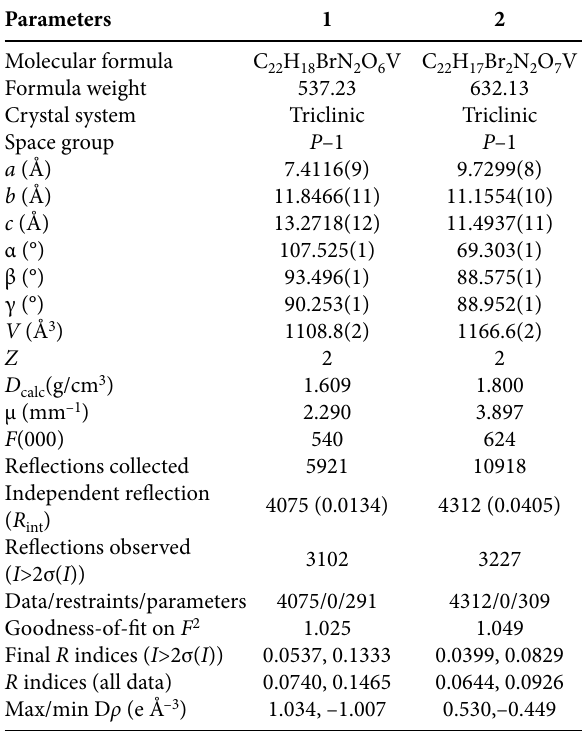
Table 1. Crystal data and structure refinement for the complexes Parameters Molecular